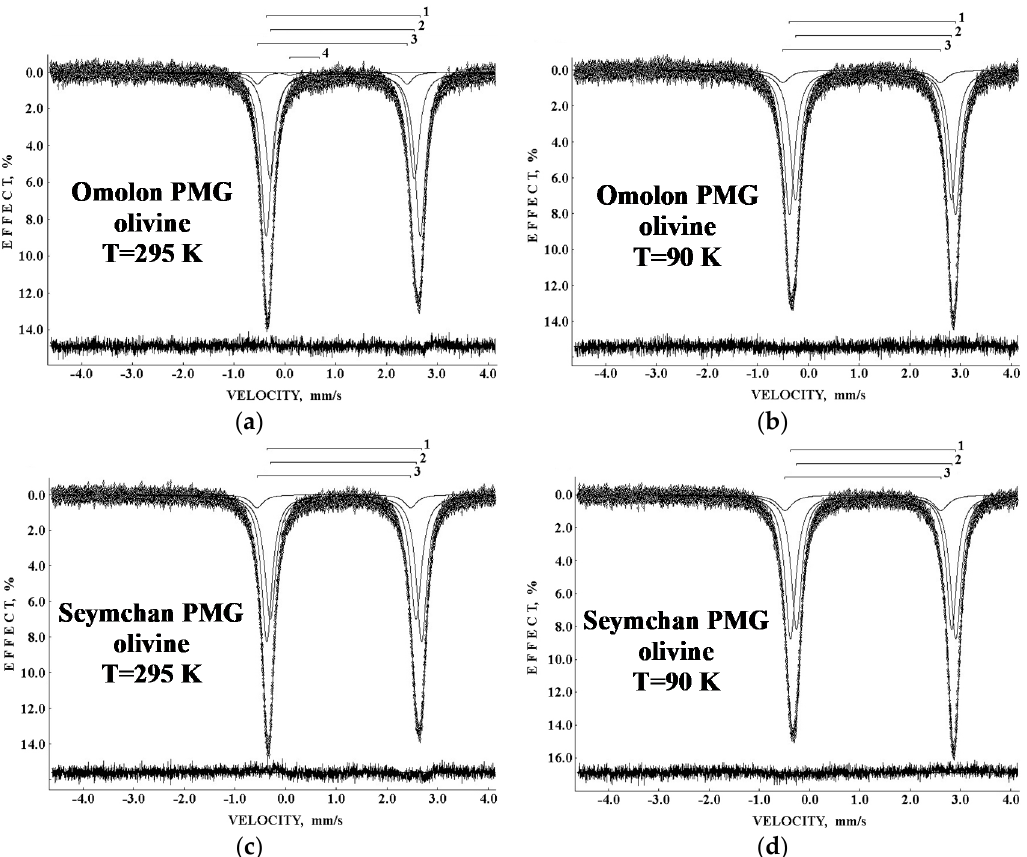
Figure 16. Mössbauer spectra of olivine extracted from the main group pallasites Omolon ( a , b ) and Seymchan ( c , d ) measured in 4096 channels at 295 K ( a , c ) and 90 K ( b , d ). Indicated components are the results of the fits. The differential spectra are shown on the bottom. Adapted from [39].